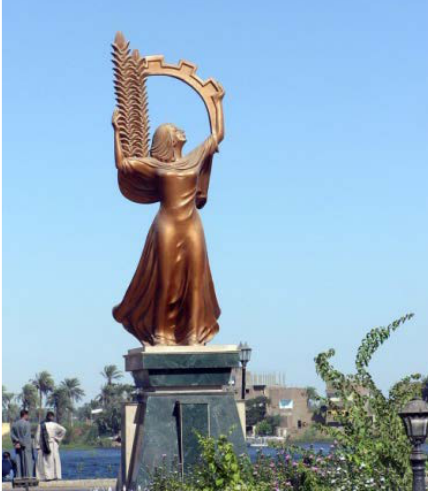
Fig. 17, "civilization" statue, Nag Hammadi, Egypt.